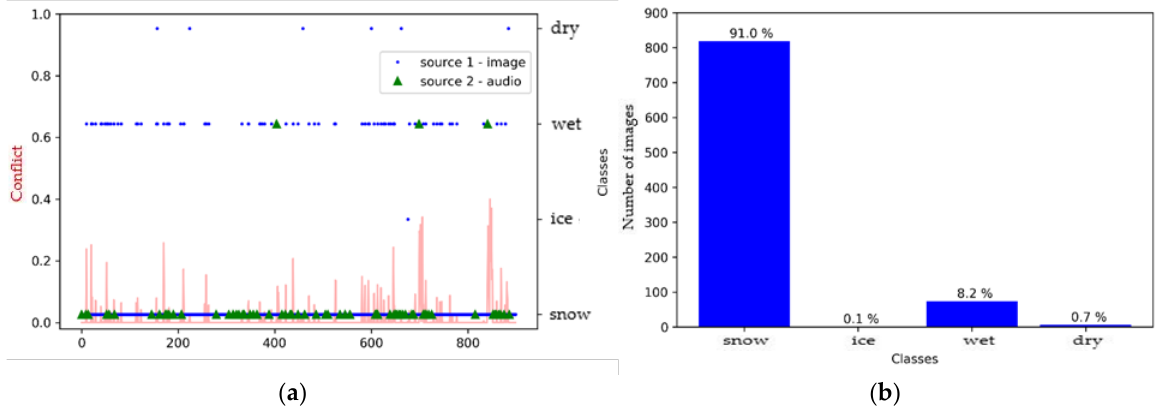
Figure 13. Environment #2. ( a ) Classification of sources with MobileNetV3_small (video) and M5 (audio) prior to fusion, together with conflict analysis; ( b ) histogram prior to image fusion.